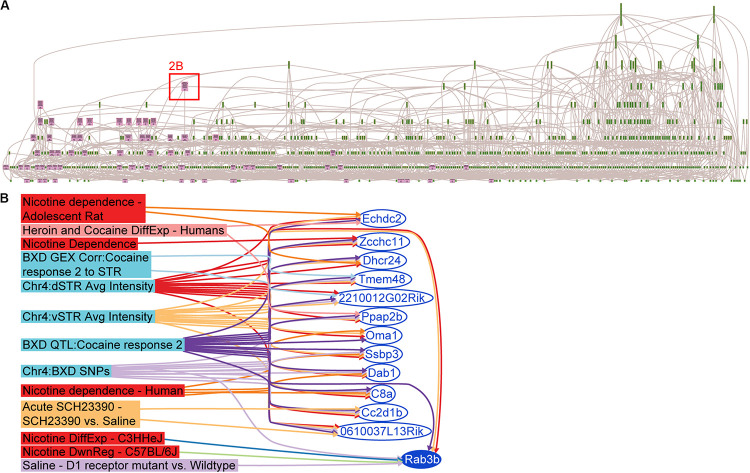
Integrative functional analysis in GeneWeaver. (A) Hierarchical Similarity tool depicting a hierarchical representation of gene sets used in the integrative analysis. Nodes at the top are highly connected genes. Pink colored nodes represent nodes containing one or more QTL candidate genes. Rab3b is revealed as the most highly connected QTL candidate gene. (B) GeneSet graph representing the underlying interconnections among the gene sets containing Rab3b.